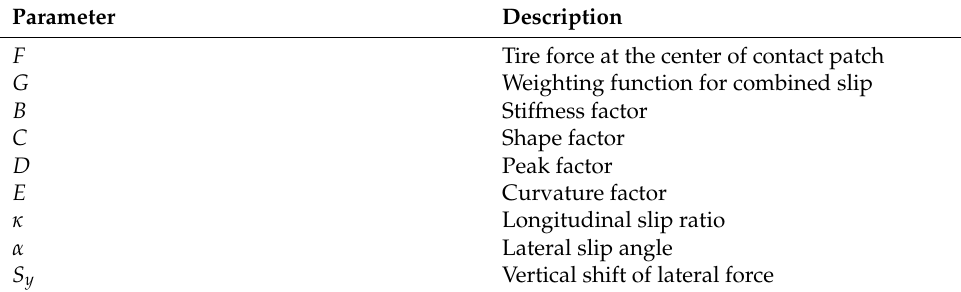
Table 1. Parameters for the magic formula. Parameter Description F Tire force at the center of contact patch